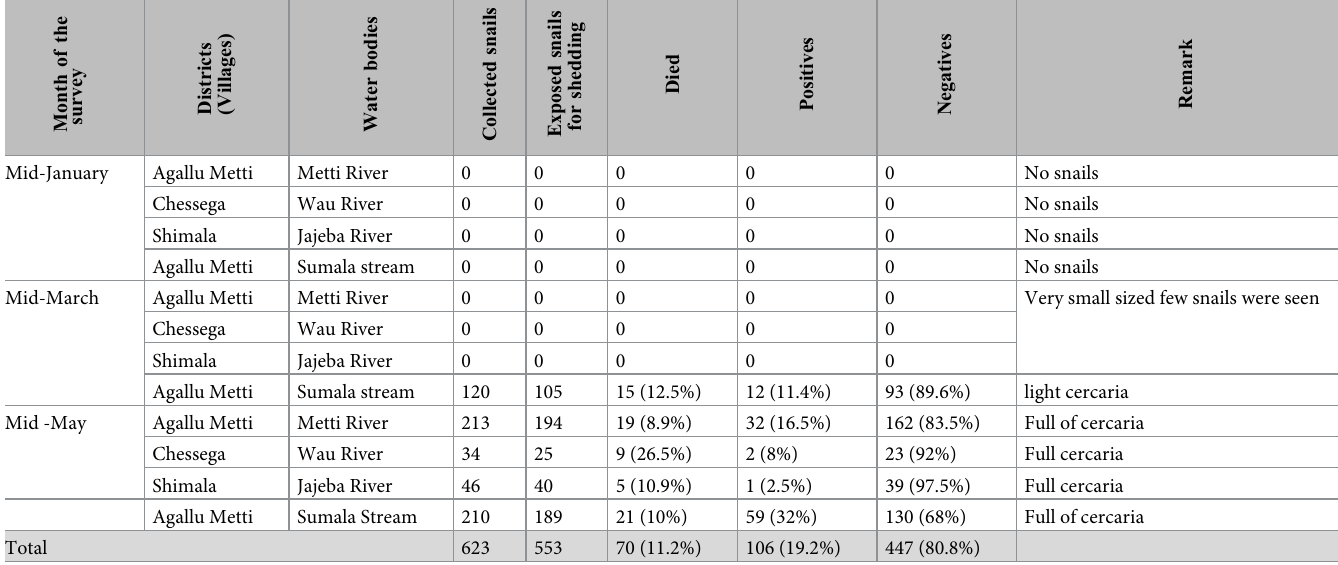
Table 3. Seasonal Biomphalaria pfeifferi snails’ distribution and infection status (n =